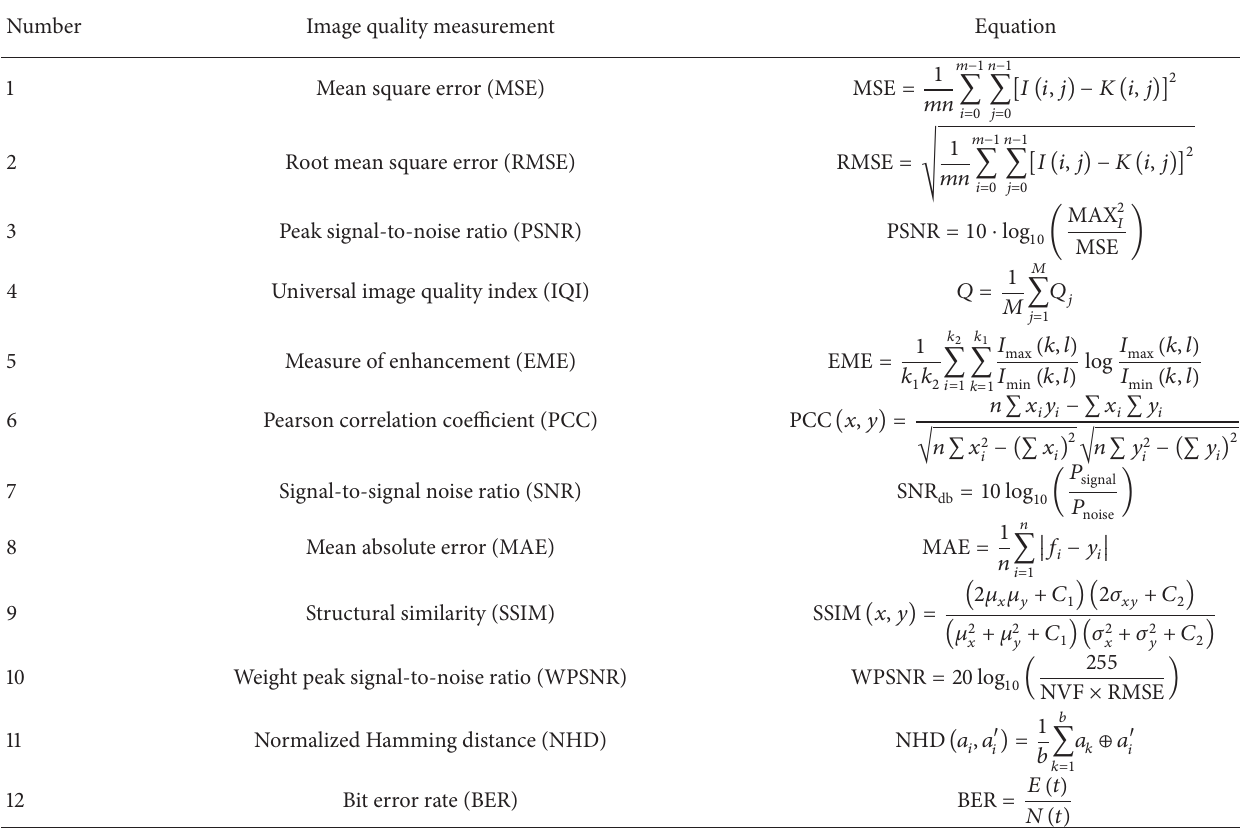
Table 2: Common image quality metrics.